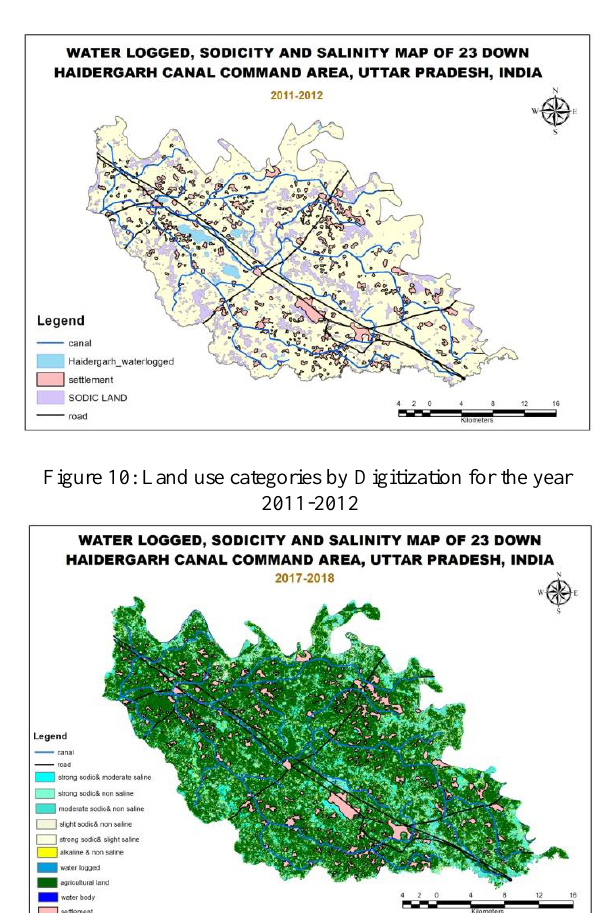
Figure 7: Land use categories by Unsupervised technique for the year 2017-2018